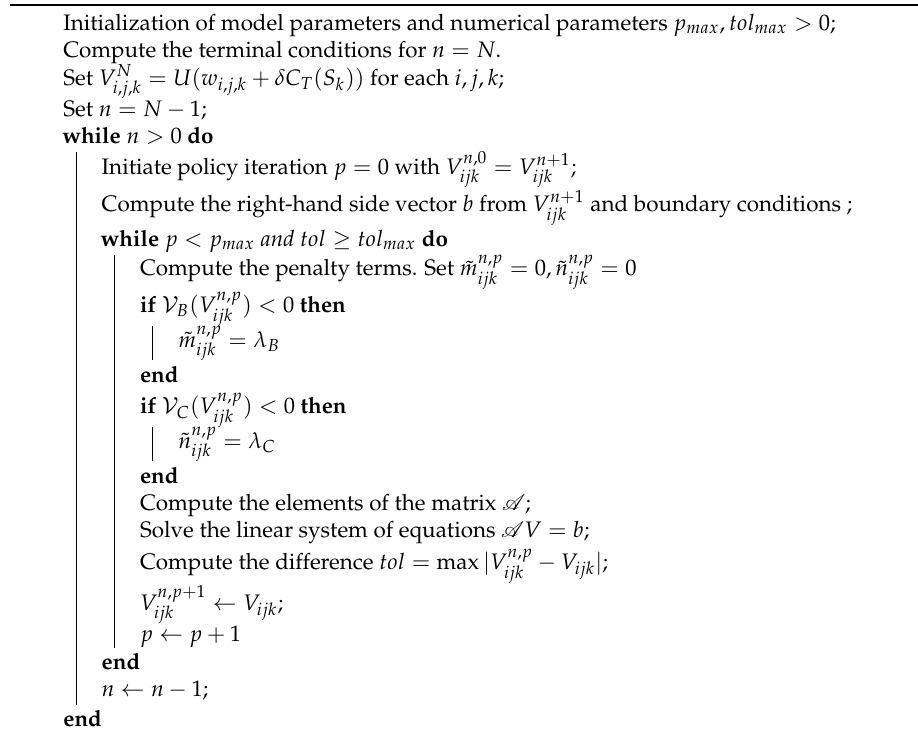
Algorithm 1: The algorithm for computing the value function V for δ = 0, ±